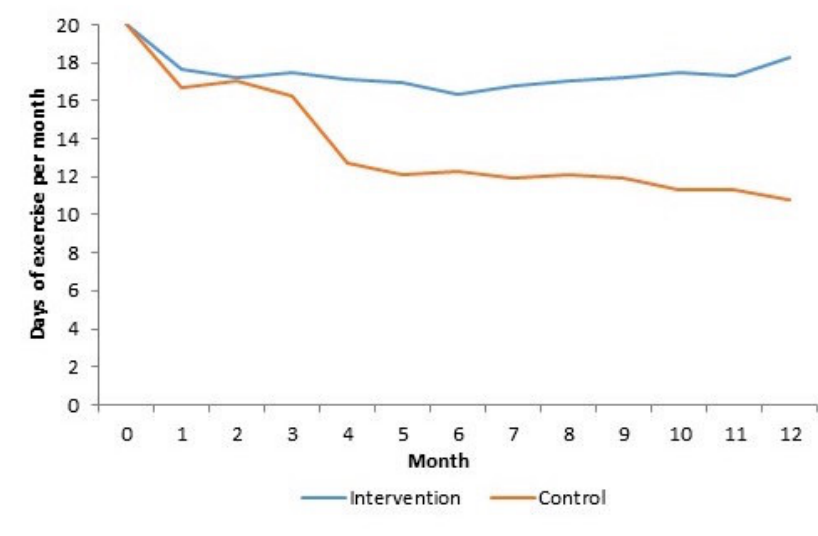
Figure 2. Monthly days of exercise by study